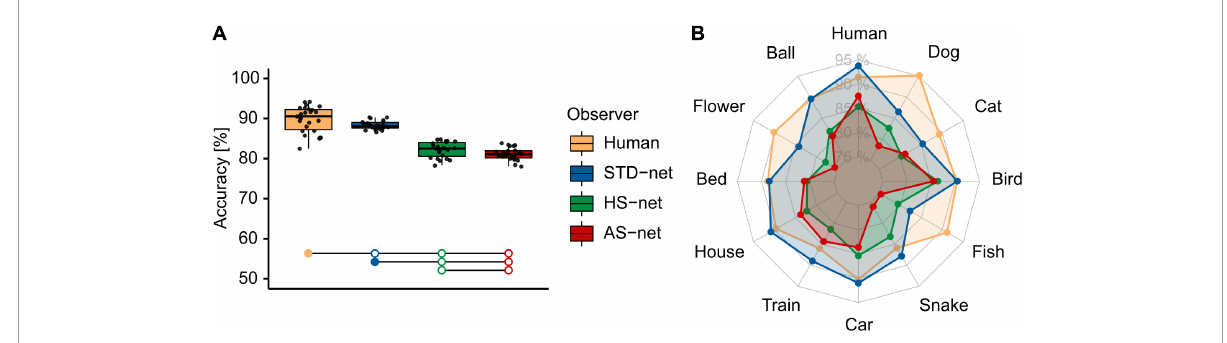
FIGURE2 Mean object recognition accuracy of human participants and DCNN runs. (A) Mean accuracy of human participants, standardly fine-tuned STD-nets, purposefully manipulated HS-nets, and inversely manipulated AS-nets across all testing images. Groups marked by filled dots outperformed groups marked by empty dots significantly at the p < 0.05 level. (B) Mean accuracy profiles across